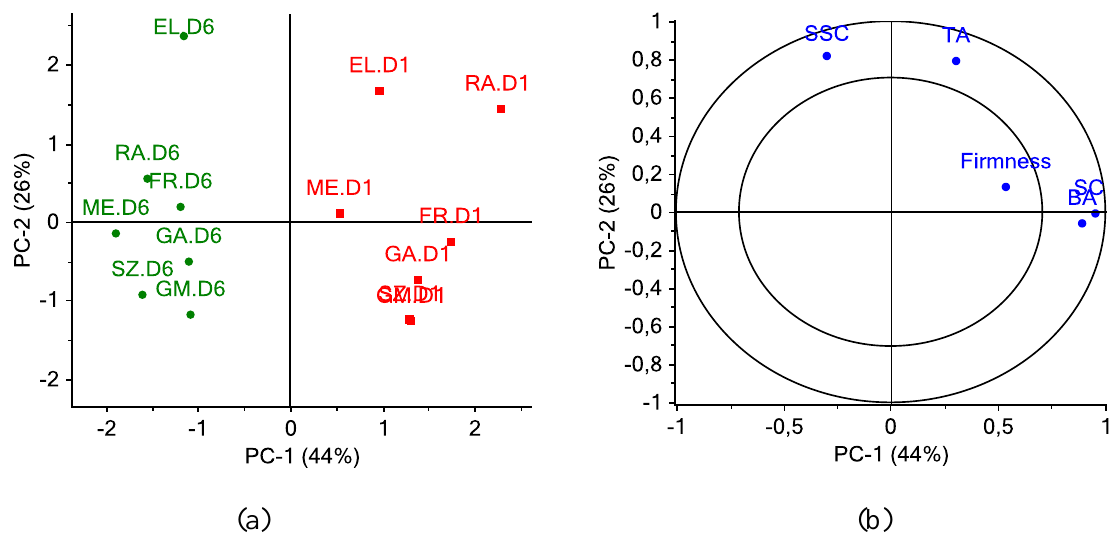
Figure 2. (a) PCA scores grouped according to shelf life storage days 1 and 6 for apples: EL—‘Elstar’, FR—‘Free Redstar’, GA—‘Gala’, GM—‘Gold Milenium’, ME—‘Melfree’, RA—‘Rajka’ and SZ—‘Szampion’. D (number)—day of shelf life. (b) Variable loadings on PC1 and PC2